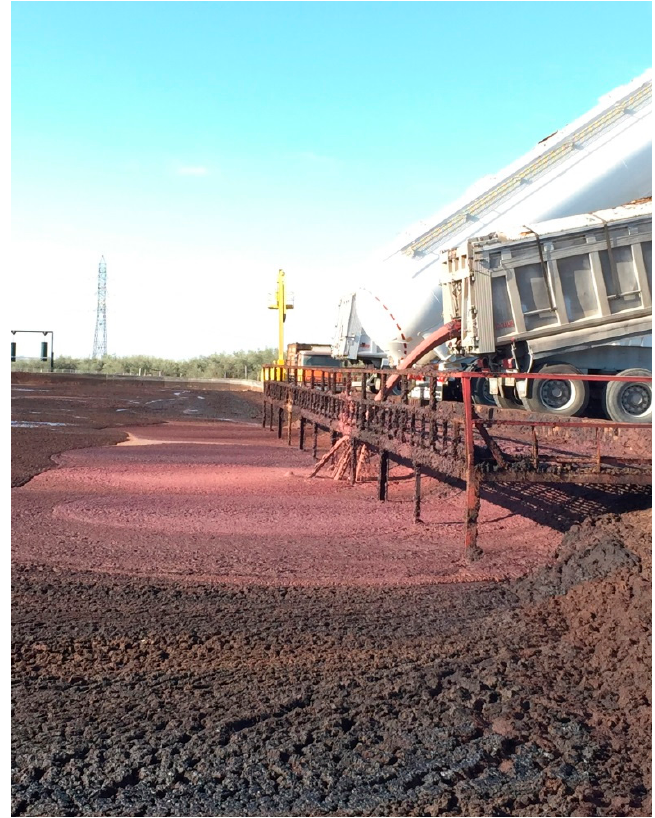
Figure 7. Olive pomace from oil mills that use the centrifugation process with a two-outlet decanter. These pomace rafts are located in the extraction plants of pomace oils.